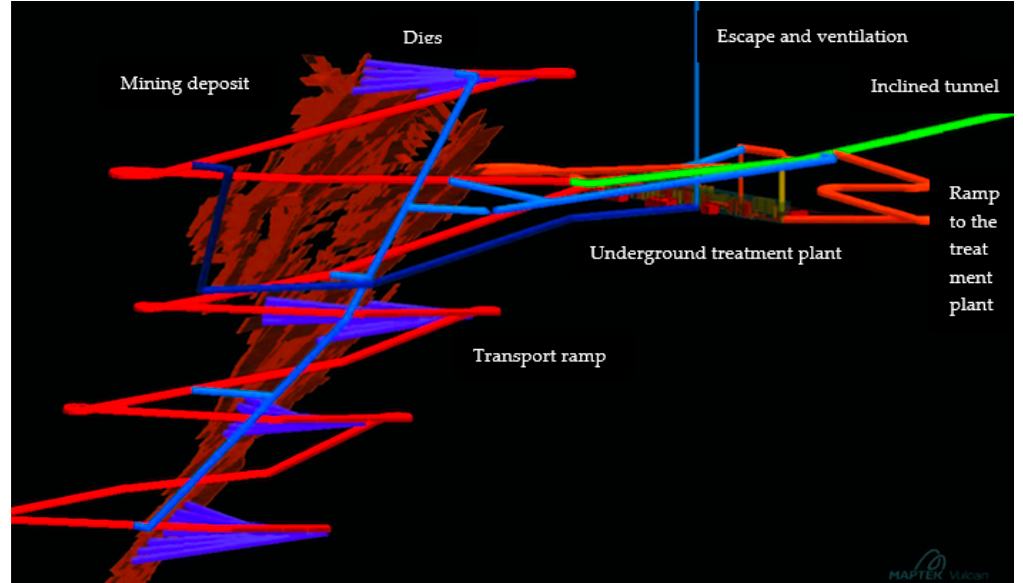
Figure 3. The deposit opening method [58].